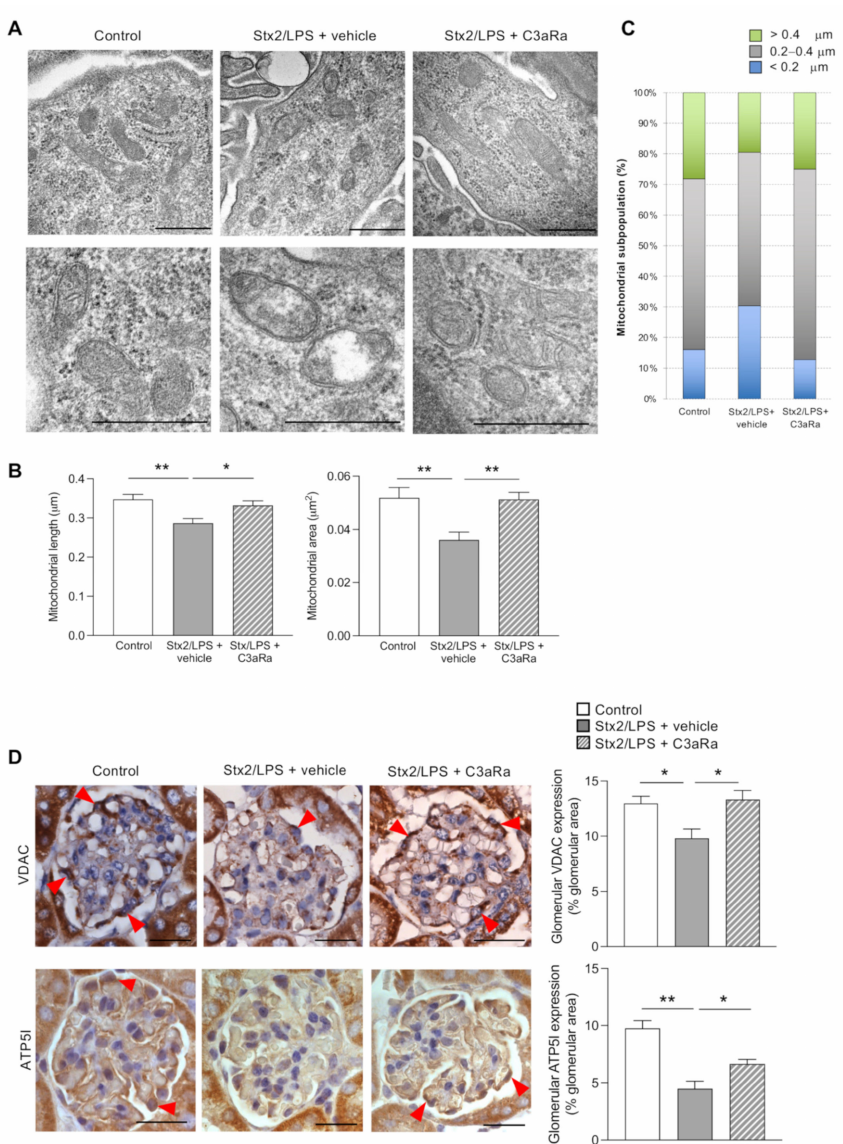
Figure 2. Treatment with the C3aR antagonist limits glomerular mitochondrial alterations in Stx2/LPS mice: ( A ) Representative transmission electron microscope images showing mitochondrial morphol- ogy in podocytes of control and Stx2/LPS mice, given vehicle or C3aR antagonist (C3aRa). Scale bars: 500 nm; ( B ) Quantification of mitochondrial length and area and ( C ) characterization of mitochondrial subpopulations in podocytes. Results are expressed as mean ± SEM (control: n = 516 mitochondria analyzed in n = 6 glomeruli of n = 2 mice; Stx2/LPS + vehicle: n = 411 mitochondria analyzed in n = 7 glomeruli of n = 3 mice; Stx2/LPS + C3aRa: n = 529 mitochondria analyzed in n = 7 glomeruli of n = 3 mice); ( D ) Representative images and quantification of glomerular VDAC (upper panels) and ATP5I (bottom panels) staining in controls and Stx2/LPS mice given vehicle or C3aRa. Podocytes are indicated by red arrowheads. Scale bars: 20 µ m. Results are expressed as mean ± SEM (VDAC: control n = 4, Stx2/LPS + vehicle n = 5, Stx2/LPS + C3aRa n = 4; ATP5I: control n = 4, Stx2/LPS + vehicle n = 7, Stx2/LPS + C3aRa n = 7), and ANOVA with Tukey multiple-comparisons test was used. * p < 0.05, ** p <